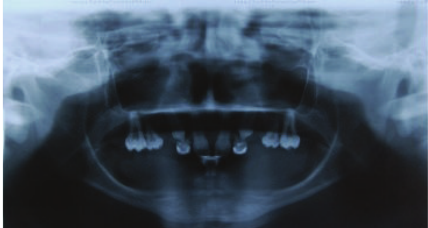
Figure 4: Panoramic radiograph view: prolonged retention of elements 52, 55, 62, and 65. The root resorption of teeth 52 and 62 can be observed, as well as the impaction of elements 13 and 23.